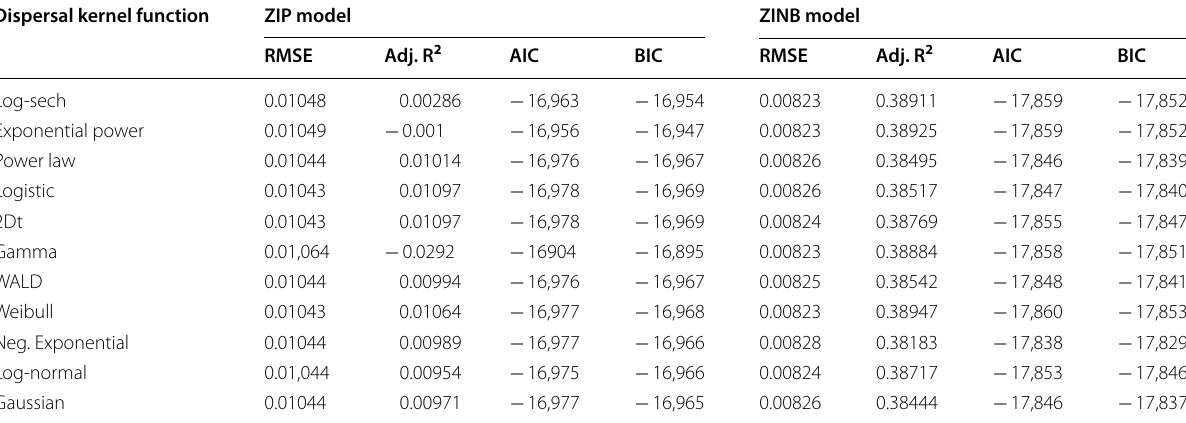
RMSE: root mean square error; adj. R 2 : adjusted coefficient of determination; AIC: Akaike’s information criterion; BIC: Schwarz’s Bayesian information criterion; MSPR: mean squared prediction error